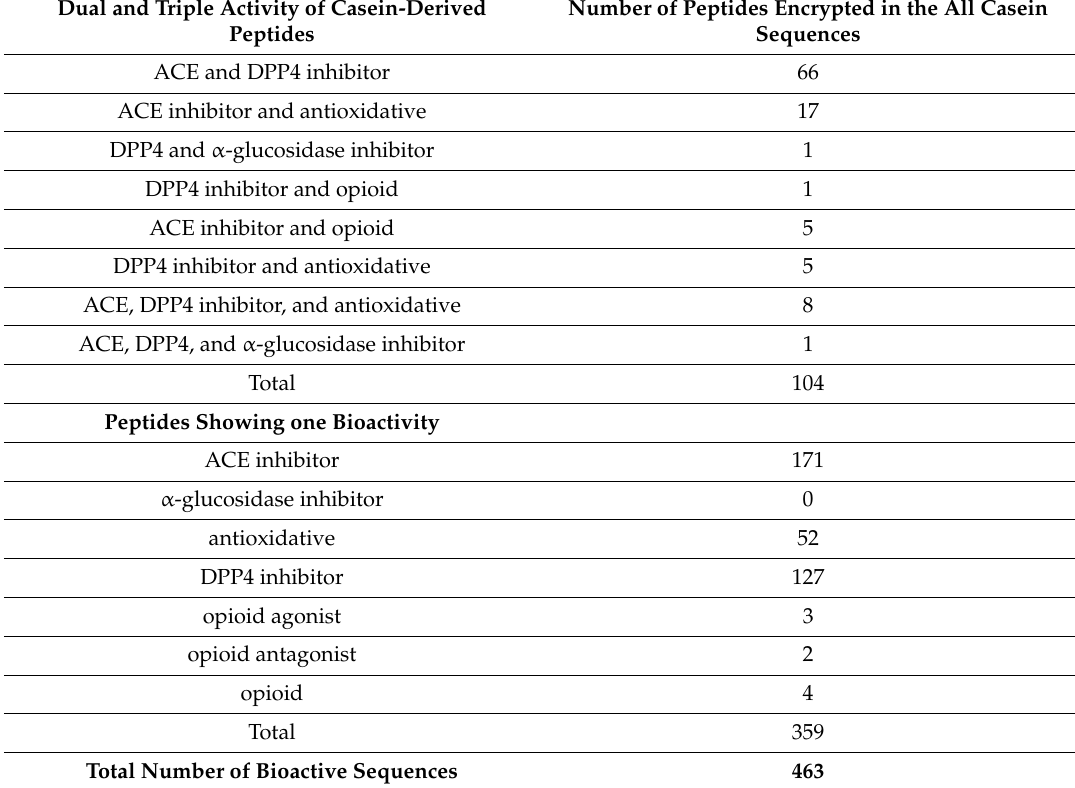
Table 4. The summary of casein-derived peptides showing more than one biological activity (based on BIOPEP-UWM database screening; http: // www.uwm.edu.pl / biochemia; accessed on March